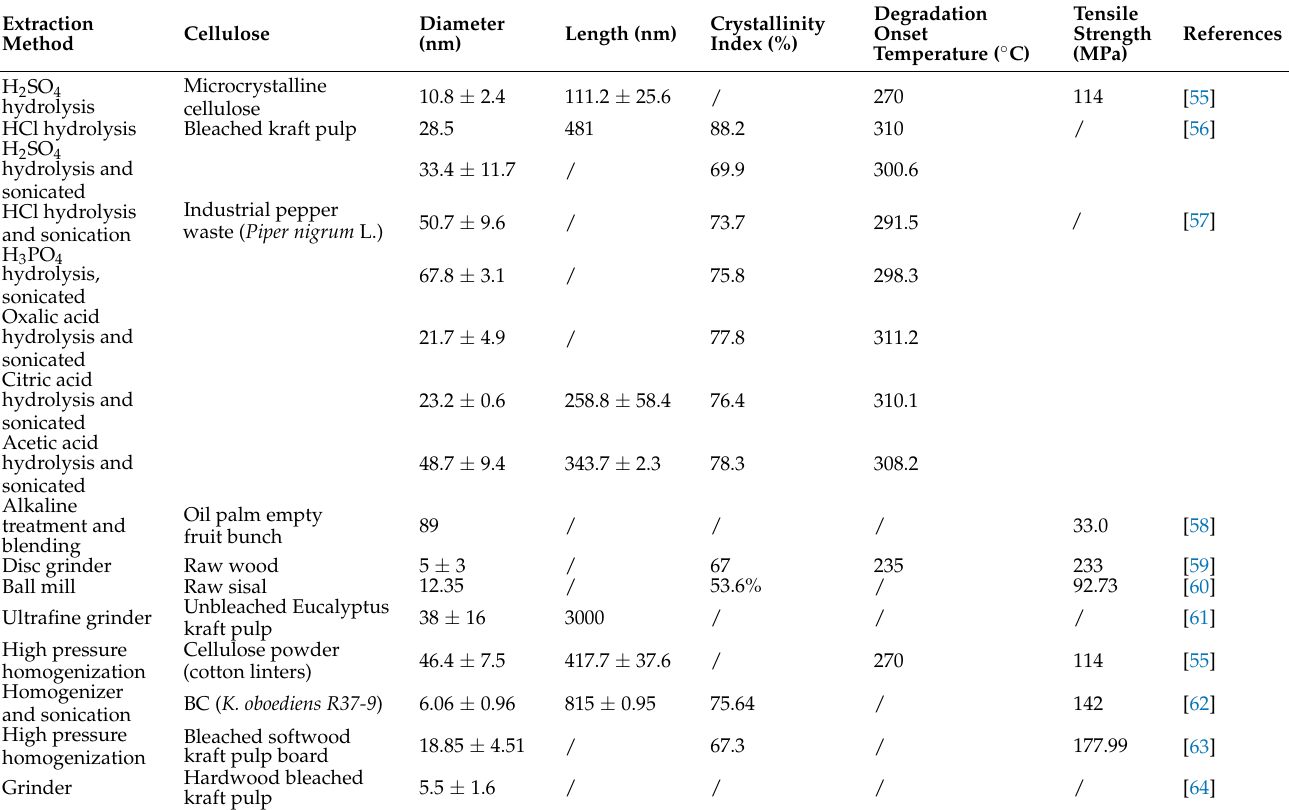
Table 2. Preparation and properties of nanocellulose produced by different